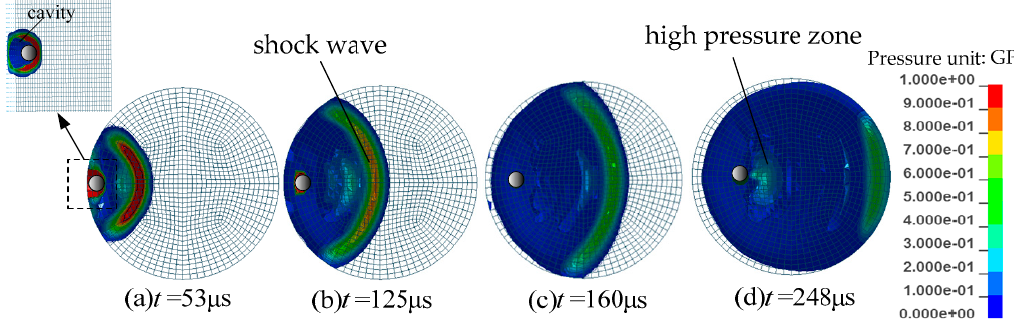
Figure 6. The pressure nephogram of the shock wave in the satellite tank at 53 µ s, 125 µ s, 160 µ s, and 248 µ s.